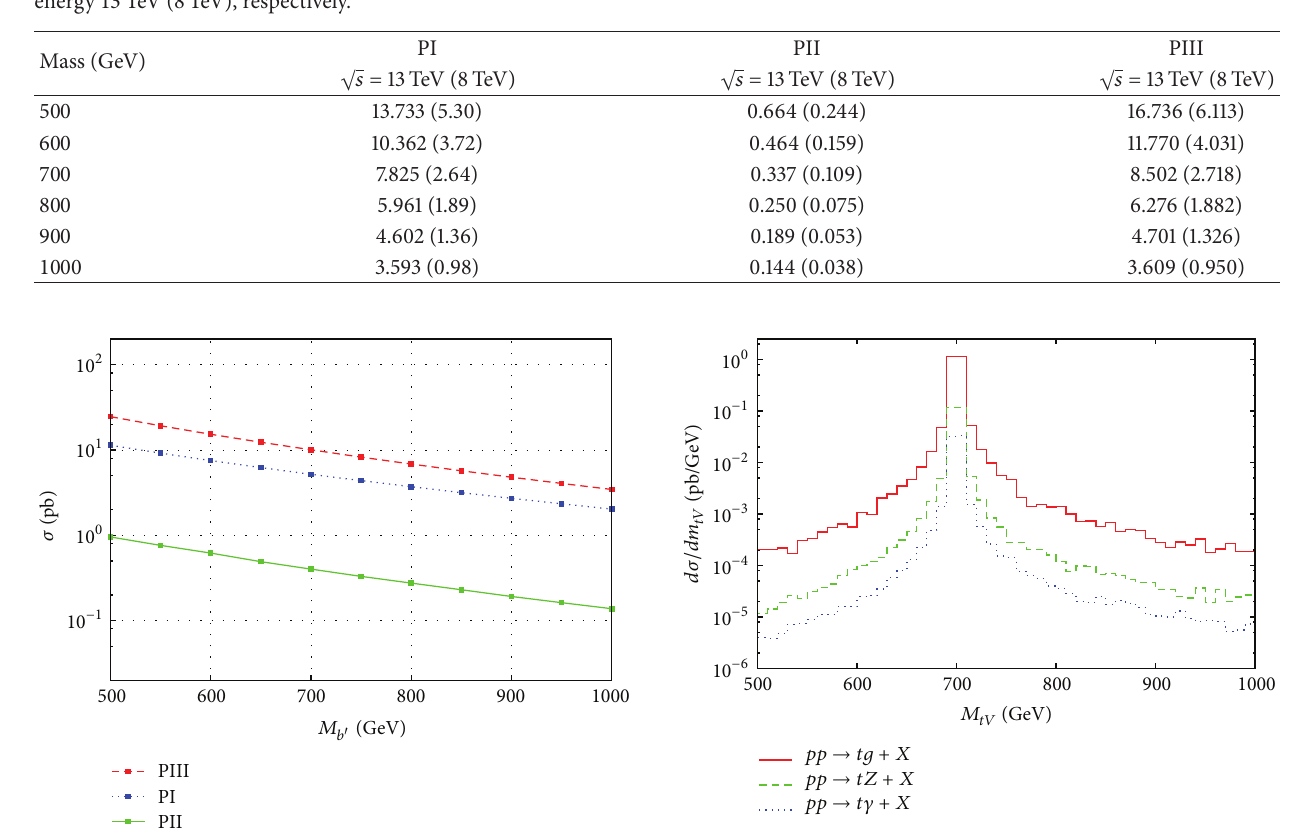
Table 5: The cross sections (in pb) of new heavy quark 𝑡 󸀠 production without cuts for PI, PII, and PIII parametrizations at the center of mass energy 13 TeV ( 8 TeV), respectively.